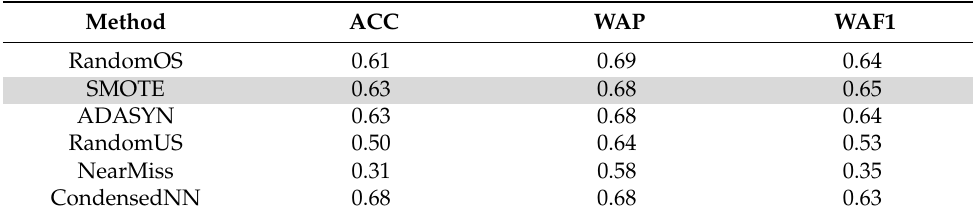
Table 5. Classification results using the SVM algorithm.